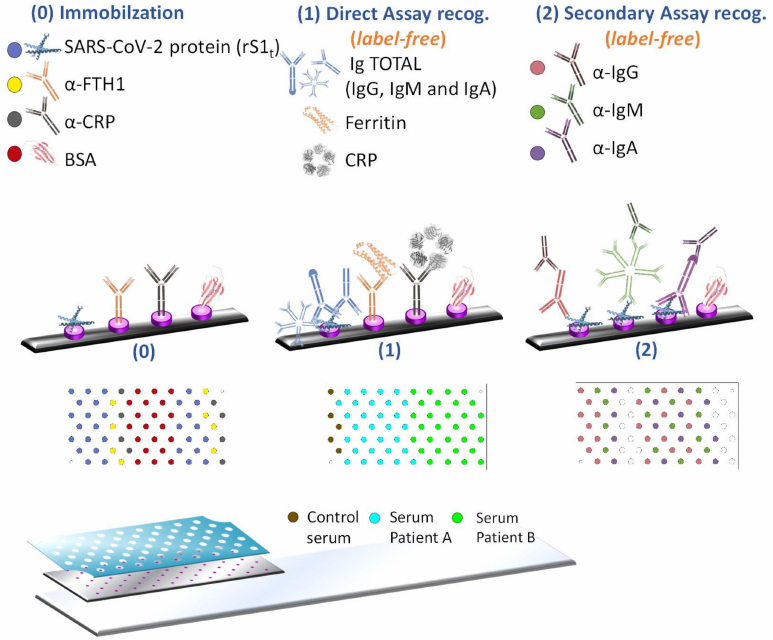
Figure 2. Depiction of the methodology followed for SARS-CoV-2 detection. The diagnostic kit used for the multiplexed diagnosis (on the bottom of the figure) is composed of 65 biosensing sites (purple dots represented in the picture) made of SU-8 epoxy resist and fabricated on a Silicon substrate chip placed on a glass slide to facilitate its handling. The upper layer is a PVC container (a blue sheet on the image), which holds/separates the micro-volume samples. To carry out the assay, as a first step (0), the immobilization of specific bioreceptors is performed. Later, in step (1), the direct recognition of SARS-CoV-2 specific biomarkers sIgTs, FER, and CRP is measured from three different types of serum samples (two samples from unknown patients, and a control serum). Finally, step (2) determines the biosensing signal of sIgG, sIgM, and sIgA through incubation with secondary antibodies. Abbreviations: Severe Acute Respiratory Syndrome Coronavirus 2 (SARS-CoV-2), Anti- Ferritin heavy chain ( α -FTH1) and anti-C Reactive Protein ( α -CRP), recombinant SARS-CoV-2 spike protein (rS1), Bovine Serum Albumin (BSA) and C Reactive Protein